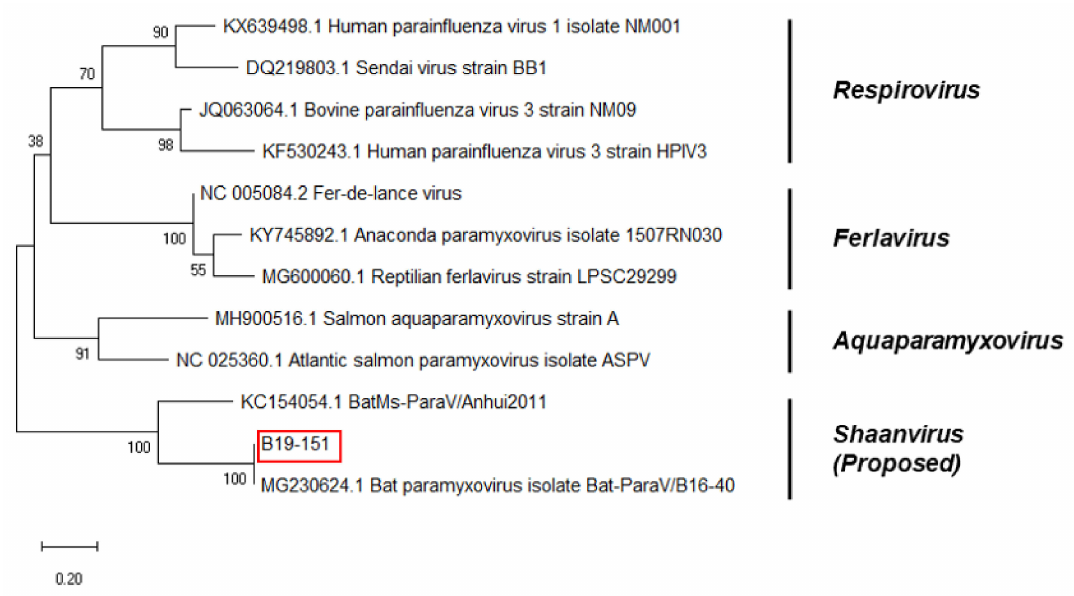
Figure 4. Phylogenetic analysis based on partial Hemagglutinin Neuraminidase (HN) nucleotide sequences of bat paramyxoviruses detected in Korean bats and other reference viruses belonging to Paramyxoviridae . The phylogenetic tree was generated via the maximum-likelihood method with 1000 replicates of bootstrap sampling and Kimura 2-parameter model using MEGA X. Korean bat paramyxoviruses are indicated by red